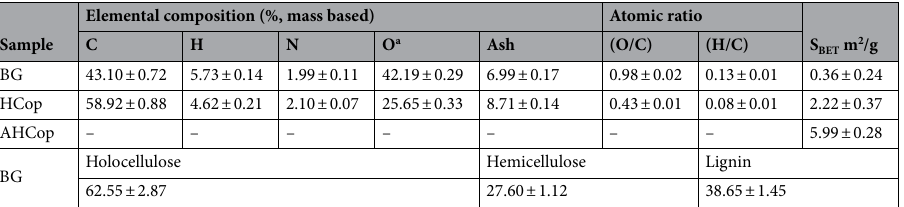
Table 2. Proximate analysis of bagasse and hydrochar in optimum conditions. a The content of O is calculated according to the equation: (100 − (C + H + N +